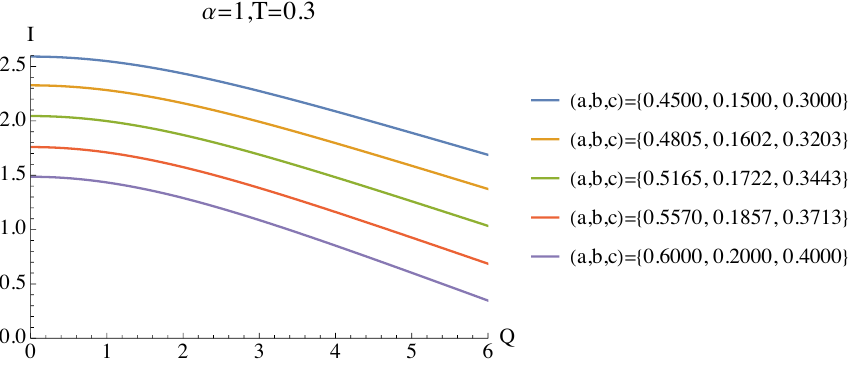
Figure 9 . The MI vs Q in different configurations ( a, b, c ) taking the same proportion between a , b and c . The MI decreases with the increasing charge Q and the larger ( a, b, c )